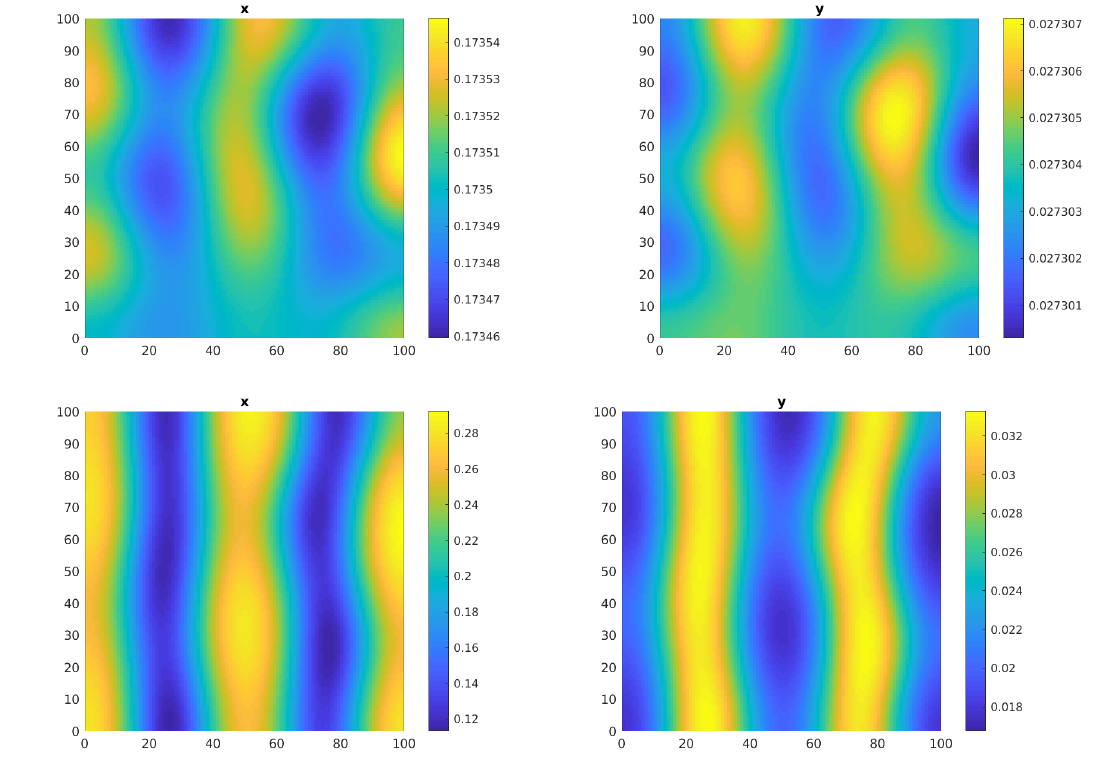
Figure 9. Plots of the solutions x and y of system (2)–(5) in the parameter setting of Example 2 for T = 2000 (first row) and T = 5000 (second row). Here it is γ 11 = 1, γ 22 = 10, γ 12 = 0.1 and γ 21 =